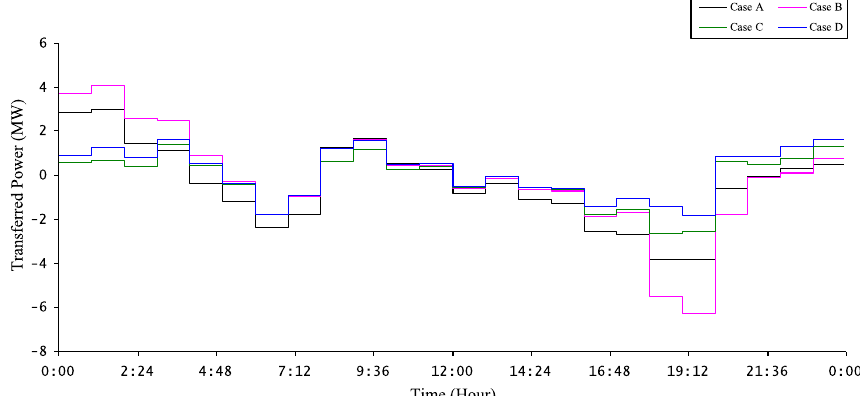
Fig. 9 Hourly exchange power under four cases (Positive power denotes the power delivering from the microgrid to external system. Negative power expresses the power sending from the external system into